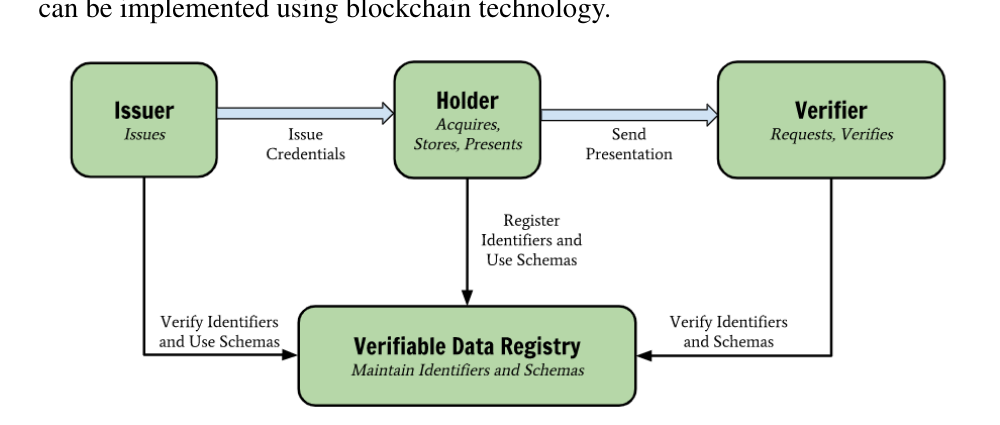
Fig. 3. The roles and information flows forming the basis for Verifiable Credential Data Model specifica-